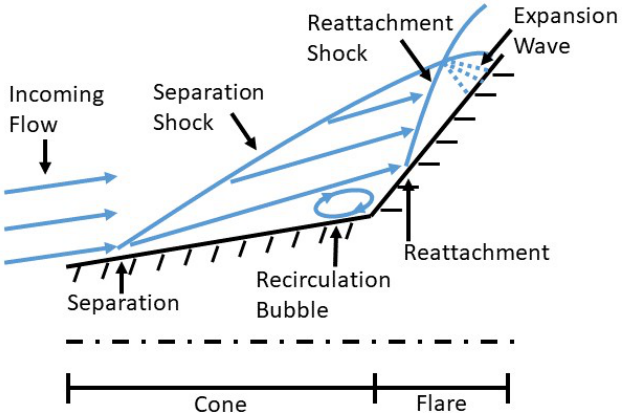
Figure 1. Cone/flare shock-wave/boundary-layer interaction schematic (from Running et al.